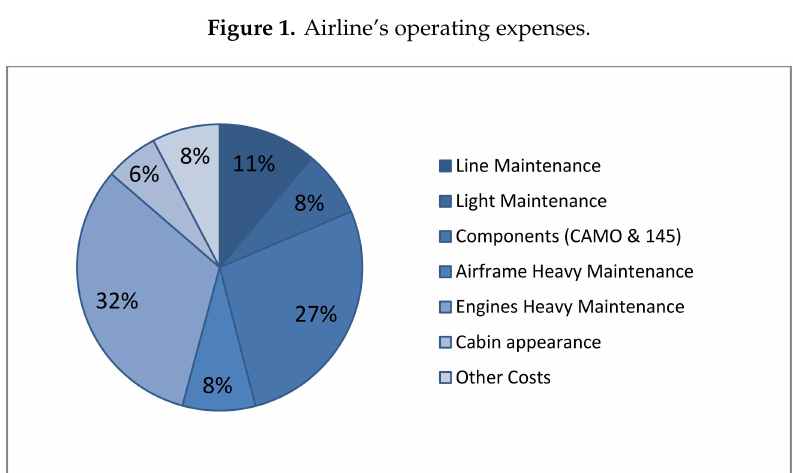
Figure 2. Engine airline’s operating